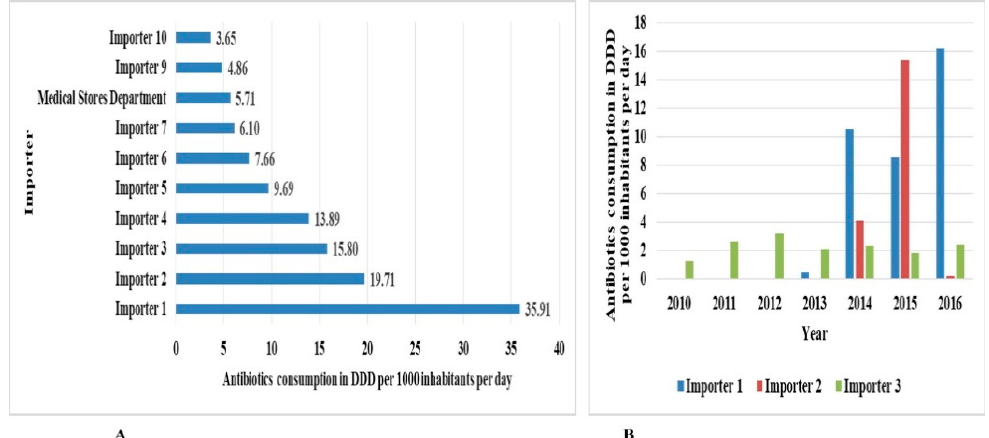
Figure 7. Top (foreign) suppliers of antibiotics utilized in Tanzania between 2010 and 2016. Panel ( A ) shows the top 10 importers, and panel ( B ) shows the annual distribution of the top 3 importers.